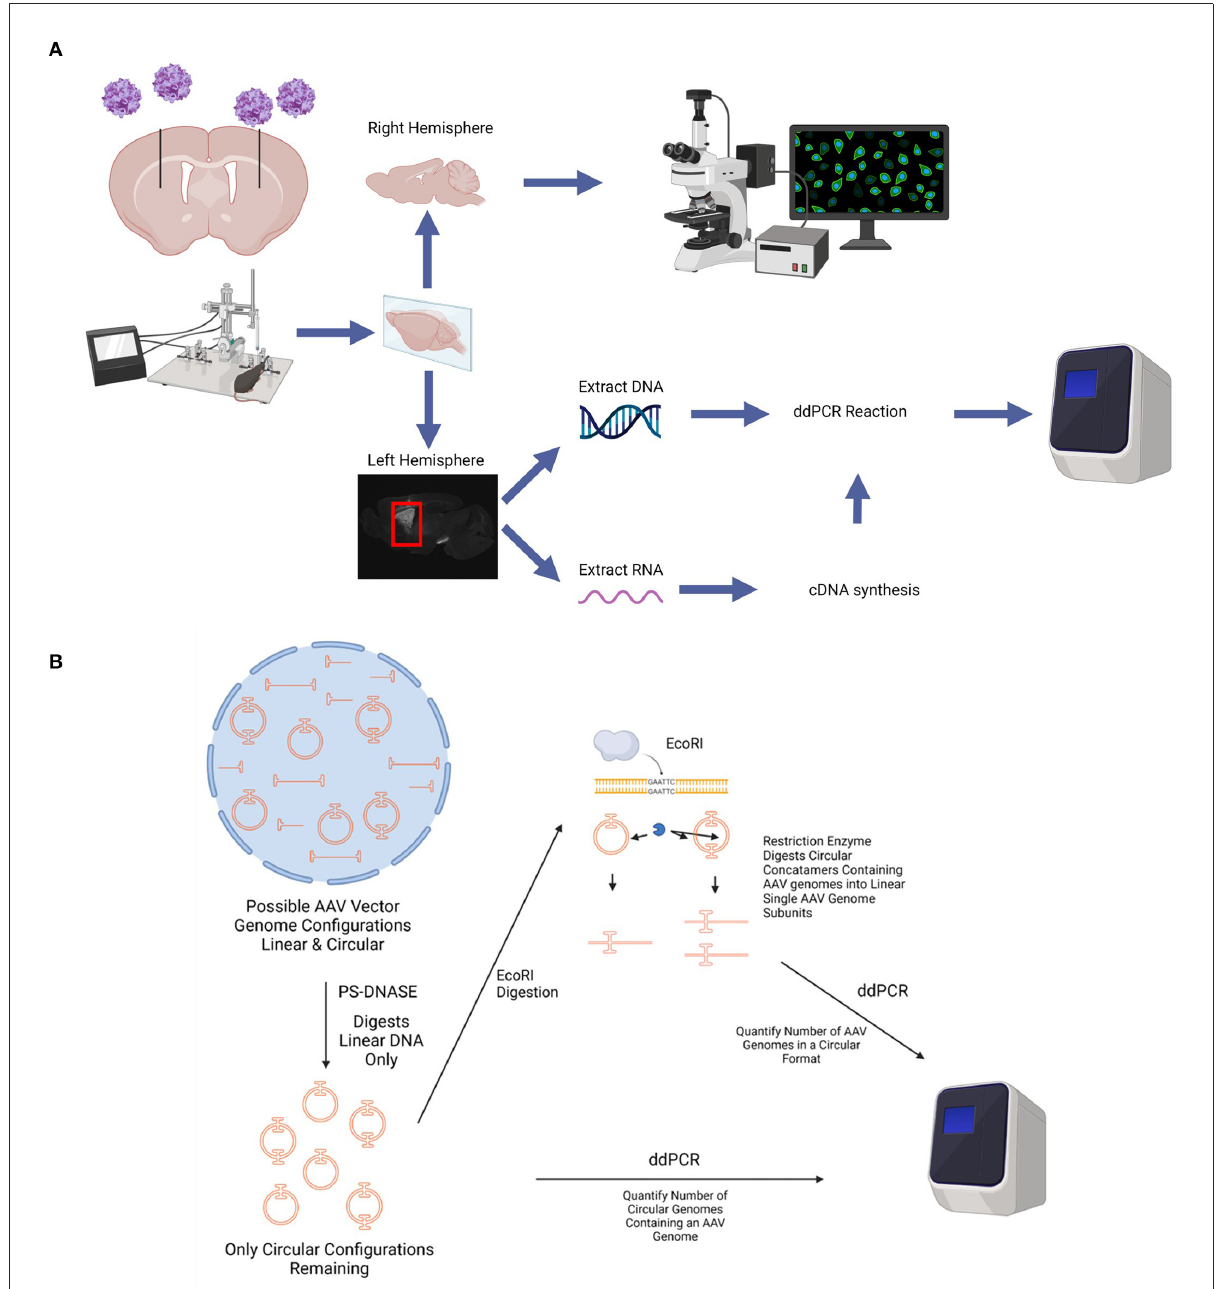
FIGURE1 Diagram of in vivo experimental paradigm. (A) rAAV9 encoding GFP under the promoters CAG, hSyn, or CamKII were stereotaxically injected into the striatum of adult (at least 6 weeks of age), female C57BL/6 mice bilaterally. At various time points after AAV administration, mice were euthanized, perfused with saline, and the brains were collected. The right hemisphere of the brain was fixed in 4% PFA, cryoprotected in a 30% sucrose solution, and sectioned using a microtome for histological analyses. The striatum from the left hemisphere was micro-dissected and frozen. DNA and RNA was extracted from each striatum. cDNA was synthesized from the RNA. The number of AAV genome copies per cell and GFP transcripts were determined using ddPCR. (B) Diagram depicting circular AAV genome quantification assay. Total DNA is extracted from tissues and treated with PS-DNASE which digests all linear AAV genomes. Only circular AAV genomes are left behind. Quantification of this population of AAV genomes on ddPCR gives number of circular AAV genomes containing an AAV genome. This does not account for different sized AAV concatemers due to an end point measurement nature of ddPCR and thus measures total number of circular DNA with an AAV genome. To quantify number of AAV genomes in a circular format, the PS-DNASE digested samples are further digested with ECORI. ECORI cuts a single time between the promoter and EGFP sequences. Concatemers with multiple AAV genomes will be digested into multiple AAV linear genome subunits. Quantification of this population of AAV genomes with ddPCR will accurately give number of AAV genomes in a circular format. Created using images from